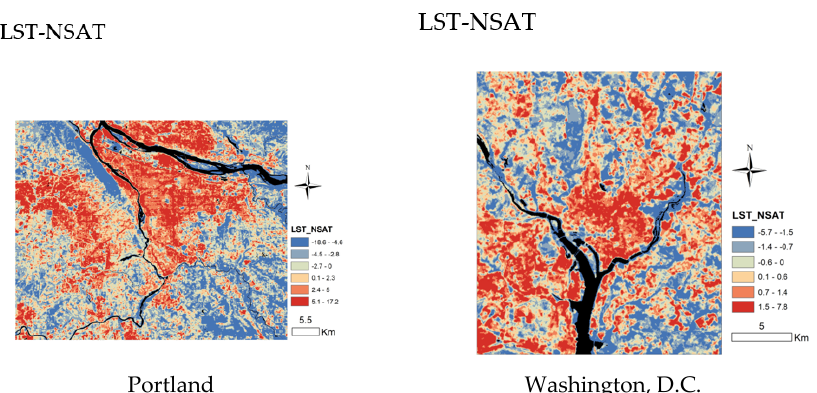
Figure 3. Temperature differences between LST and NSAT maps for Portland, Oregon ( left ), Washington, D.C. ( right ).